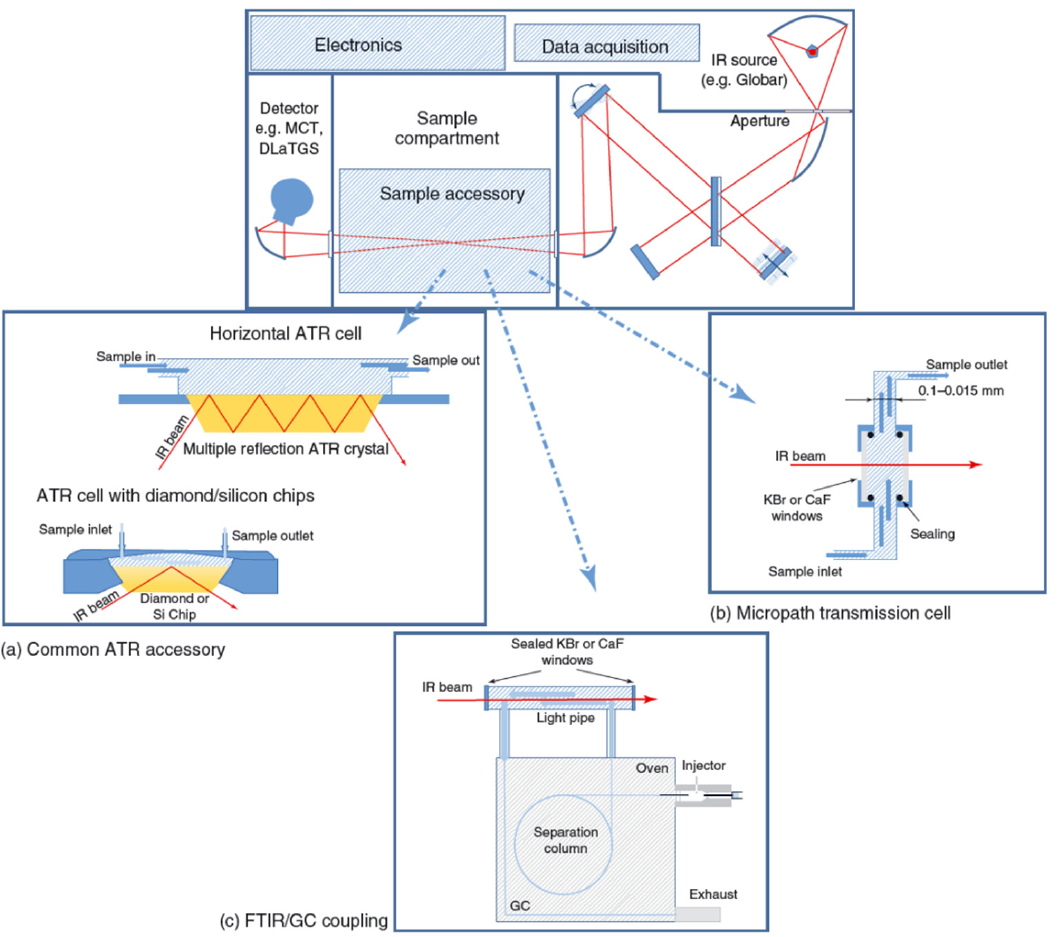
Figure 4. Combination of FTIR spectroscopy with ( a ) an ATR system, ( b ) a micropath transmission cell, and ( c ) a GC (gas chromatography) detector (e.g., DTLaGS or MCT). Reprinted with permission from Ref. [17]. Copyright © 2017, John Wiley and Sons.